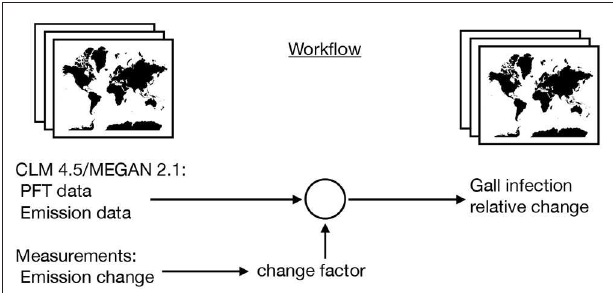
FIGURE 1 | Schematic workflow of the model to assess the maximal possible effect of gall insect-induced changes in BVOC emissions on global scale. Using MEGAN 2.1 and CLM 4.5 emission data with climate forcing in 2010 as starting point and adding information from gall-induced emission changes.